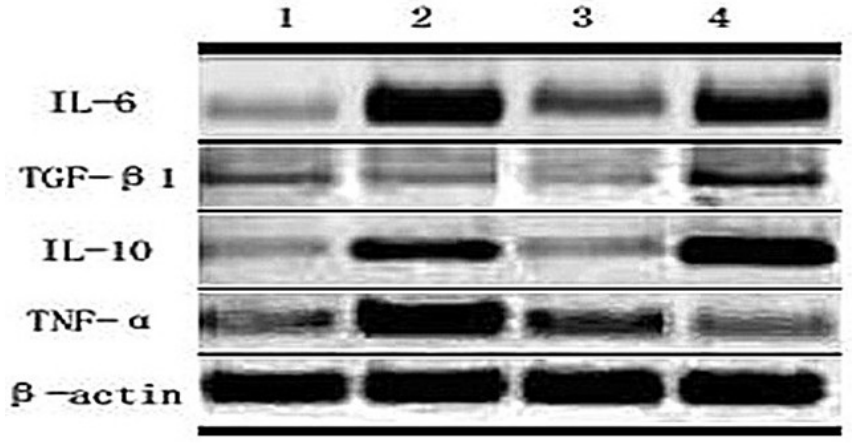
Figure 6. Expression of mRNA in the C6 cell cultured 24 h on the TiO with different diameters: ( 1 ) 15 nm-TNT; ( 2 ) 30 nm-TNT; ( 3 ) Ti; ( 4 ) control group: cell culture plate of plastic prepared from